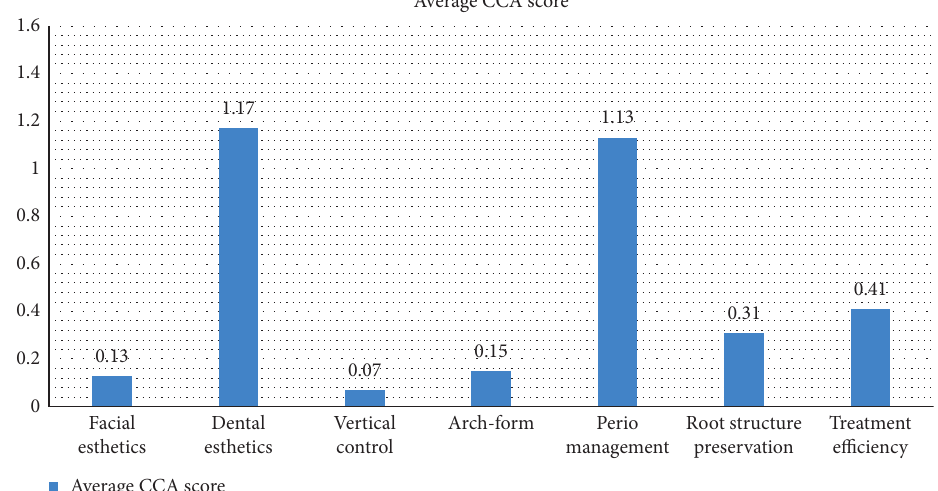
Figure 1: Average CCA score per